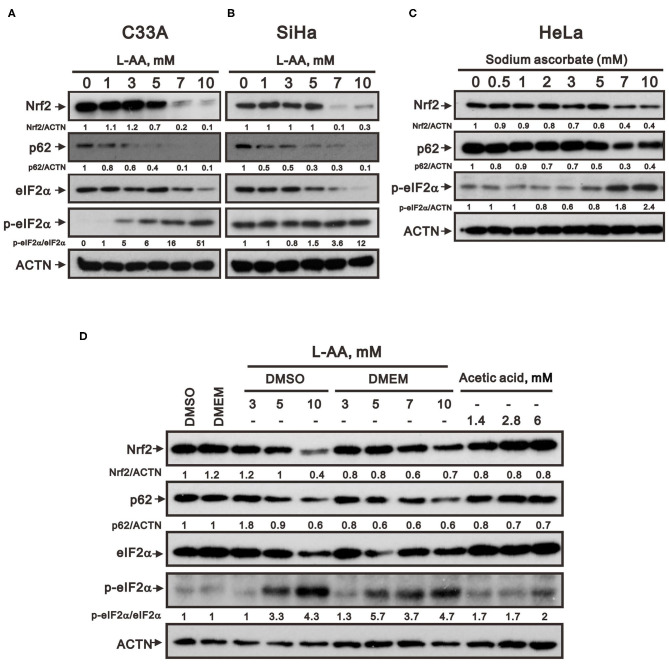
Effects of L-AA on other human cervical cancer cell lines. C33A (A) and SiHa (B) cells (2 × 105 cells/well) were incubated for 24 h with the indicated concentrations of L-AA. (C,D) HeLa cells (2 × 105 cells/well) were incubated for 24 h with the indicated concentrations of (C) sodium ascorbate or (D) indicated reagents. Cell lysates were subjected to Western blot analysis using antibodies against Nrf2, p62, e-IF2α, and p-e-IF2α. ACTN was the protein loading control. The results are representative of three independent experiments. Protein bands were quantified through pixel density scanning and evaluated using ImageJ, version 1.44a (http://imagej.nih.gov/ij/). The fold was normalized to the internal control protein (ACTN).